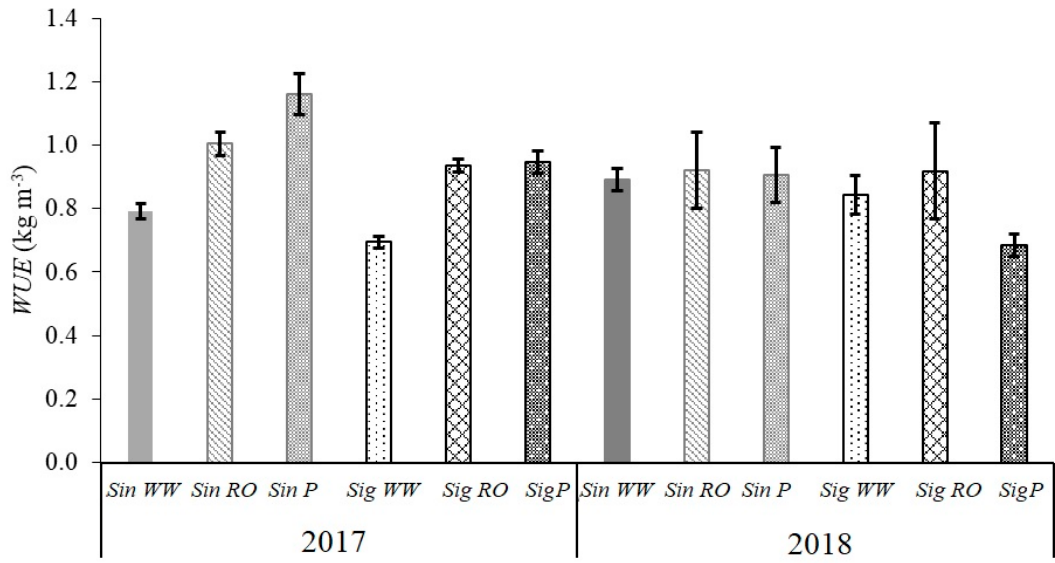
Figure 13. Water use efficiency ( WUE ) of two varieties ( Sinara : Sin ; Sigalia : Sig ) in unlimited ( WW ), water-stressed ( RO ) and rainfed ( P ) soybean, during 2017 and 2018. Values are the mean ± standard deviation of the mean ( n = 5).